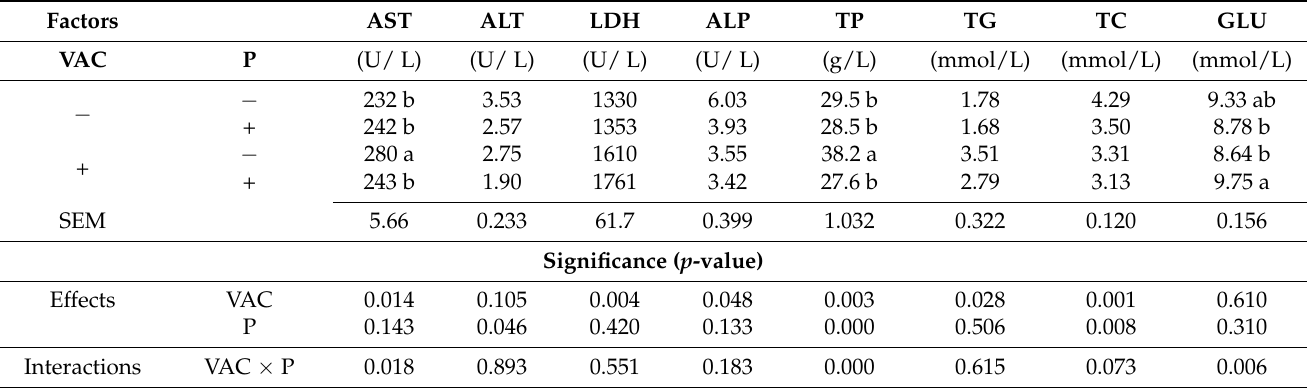
Table 5. Biochemical indices of chicken blood collected at 16 d of age.